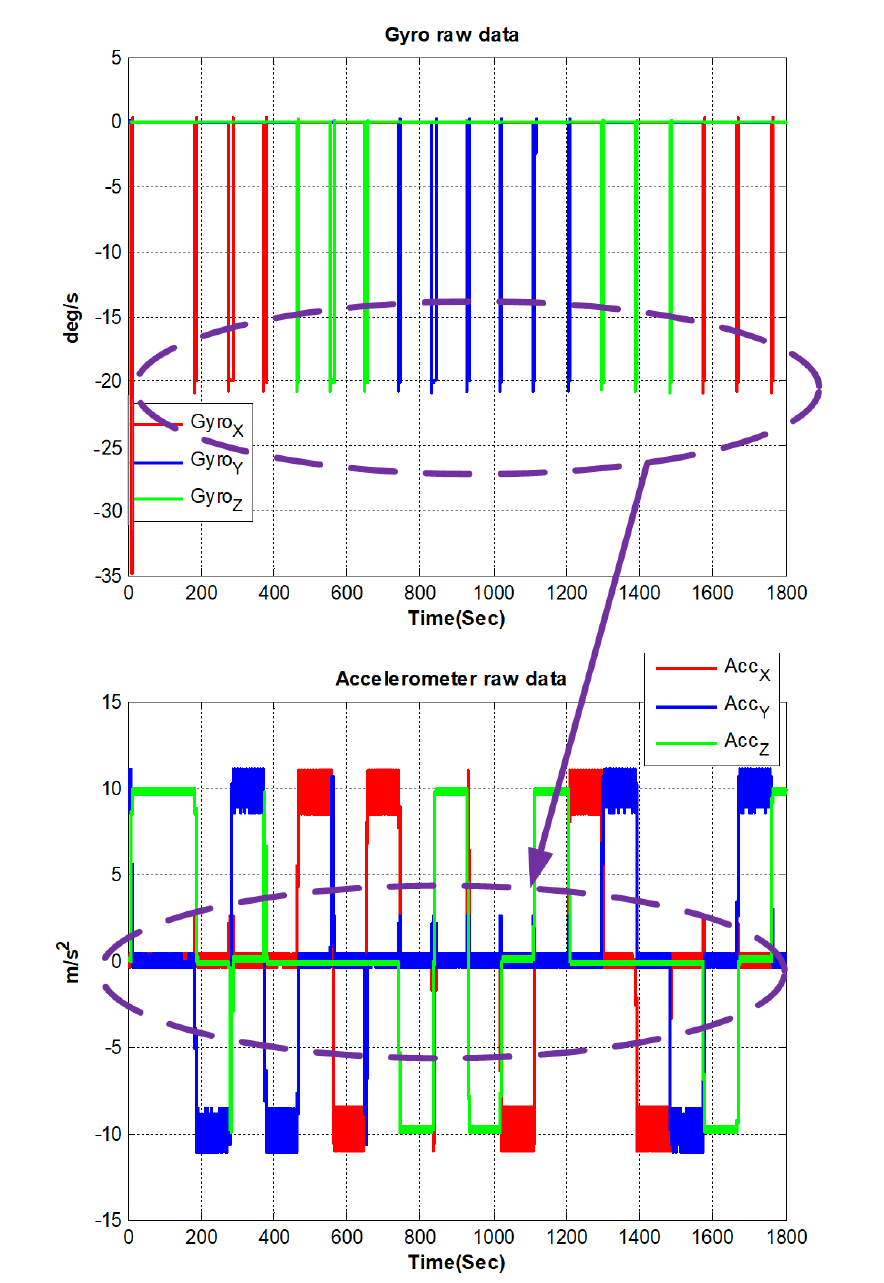
Figure 6. Raw data of PIGA-based IMU during self-calibration